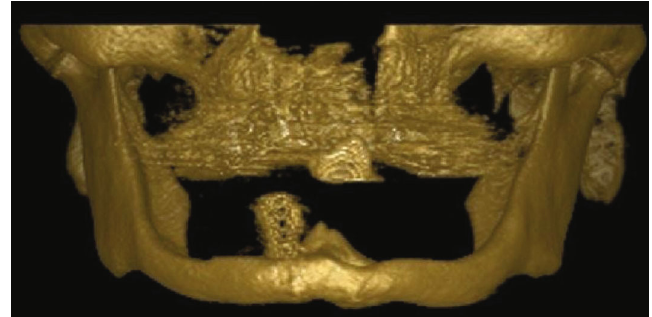
Figure 1: Three-dimensional computed tomography revealing severe mandibular atrophy with perforations at the implant sites.